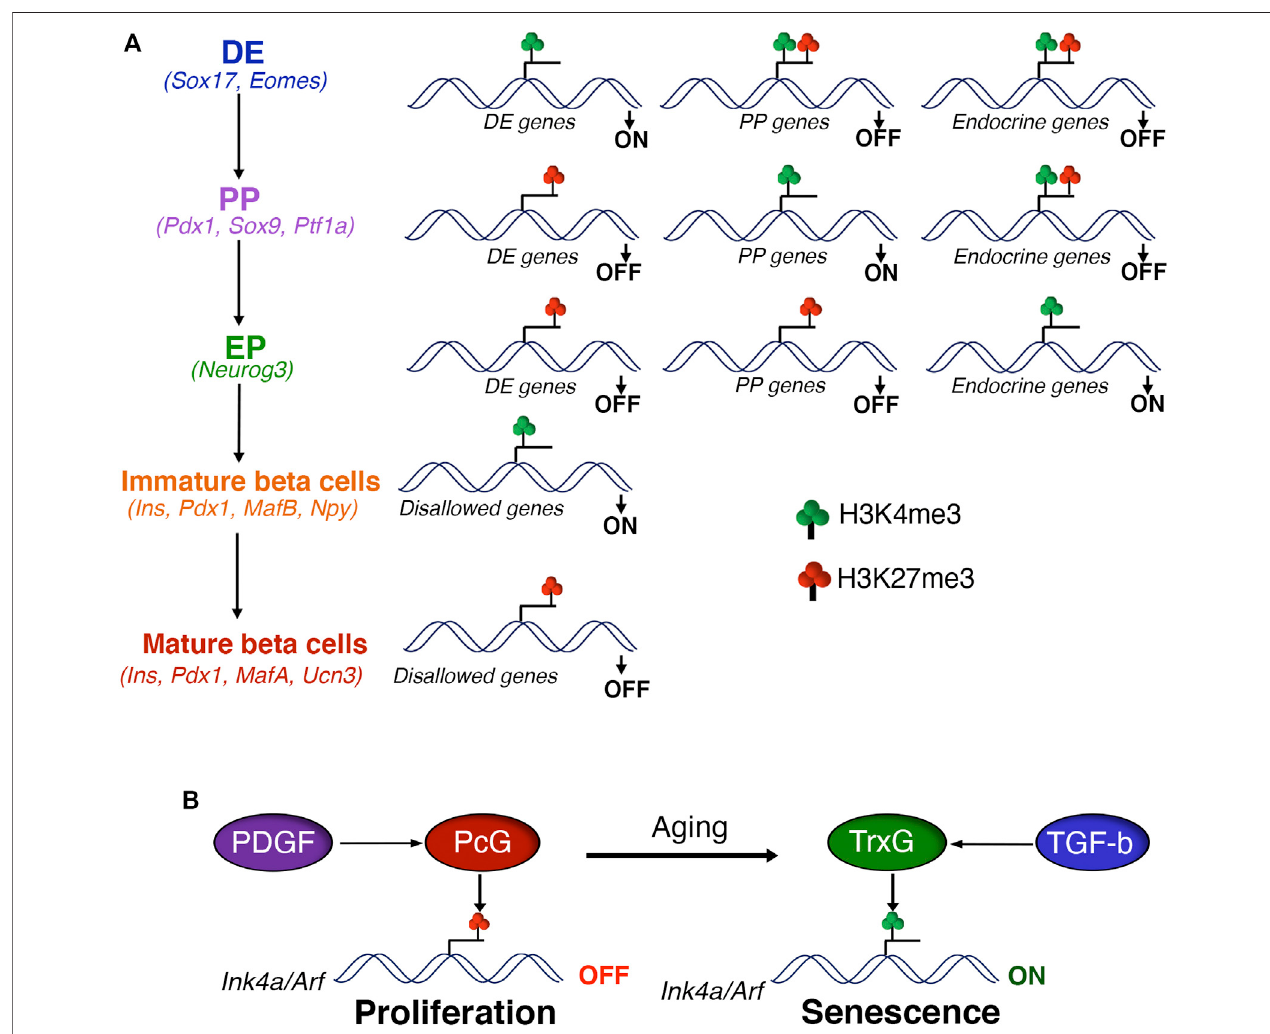
FIGURE 1 | Polycomb control of beta cell differentiation and expansion (A) Polycomb proteins regulate the differentiation of pancreatic beta cells via sequential H3K27me3 patterning of stage-speci fi c transcriptional programs. Polycomb eviction and consequent removal of H3K27me3 in response to developmental signals is essential for the activation of stage-speci fi c transcription factors during de fi nitive endoderm (DE) speci fi cation, marked by the presence of H3K4me3. The transition to pancreatic progenitors (PP) iscoupled with the PcG dependent repression of DE genes, marked by gain of H3K27me3 and loss of H3K4me3. DE induction isalso hallmarked by the creation of transcriptionally-poised chromatin state at gene promoters of pancreas speci fi cation, characterized by the presence of both H3K27me3 and H3K4me3. This regulatory process is reiterated during the subsequent stages of beta cell differentiation, such as PP to endocrine progenitors (EP) and EP to beta cells. Finally,PcG mediatedrepressionofdisallowed genessupportsthefunctional maturationofbetacells.Keygenesignaturesofeachdevelopmentalstage arenoted in parentheses. (B) PcG mediated repression of the Ink4a/Arf locus is critical for the postnatal beta cell expansion and adaptive response. Age dependent down- regulation of PcG proteins combined with increased TrxG occupancy leads to induction of Ink4a/Arf expression and beta cell senescence. Age related changes in the actvitity of growth factor signaling pathways, namely PDGF and TGF-beta, play a key role in the PcG dependent control of beta cell homeostasis.